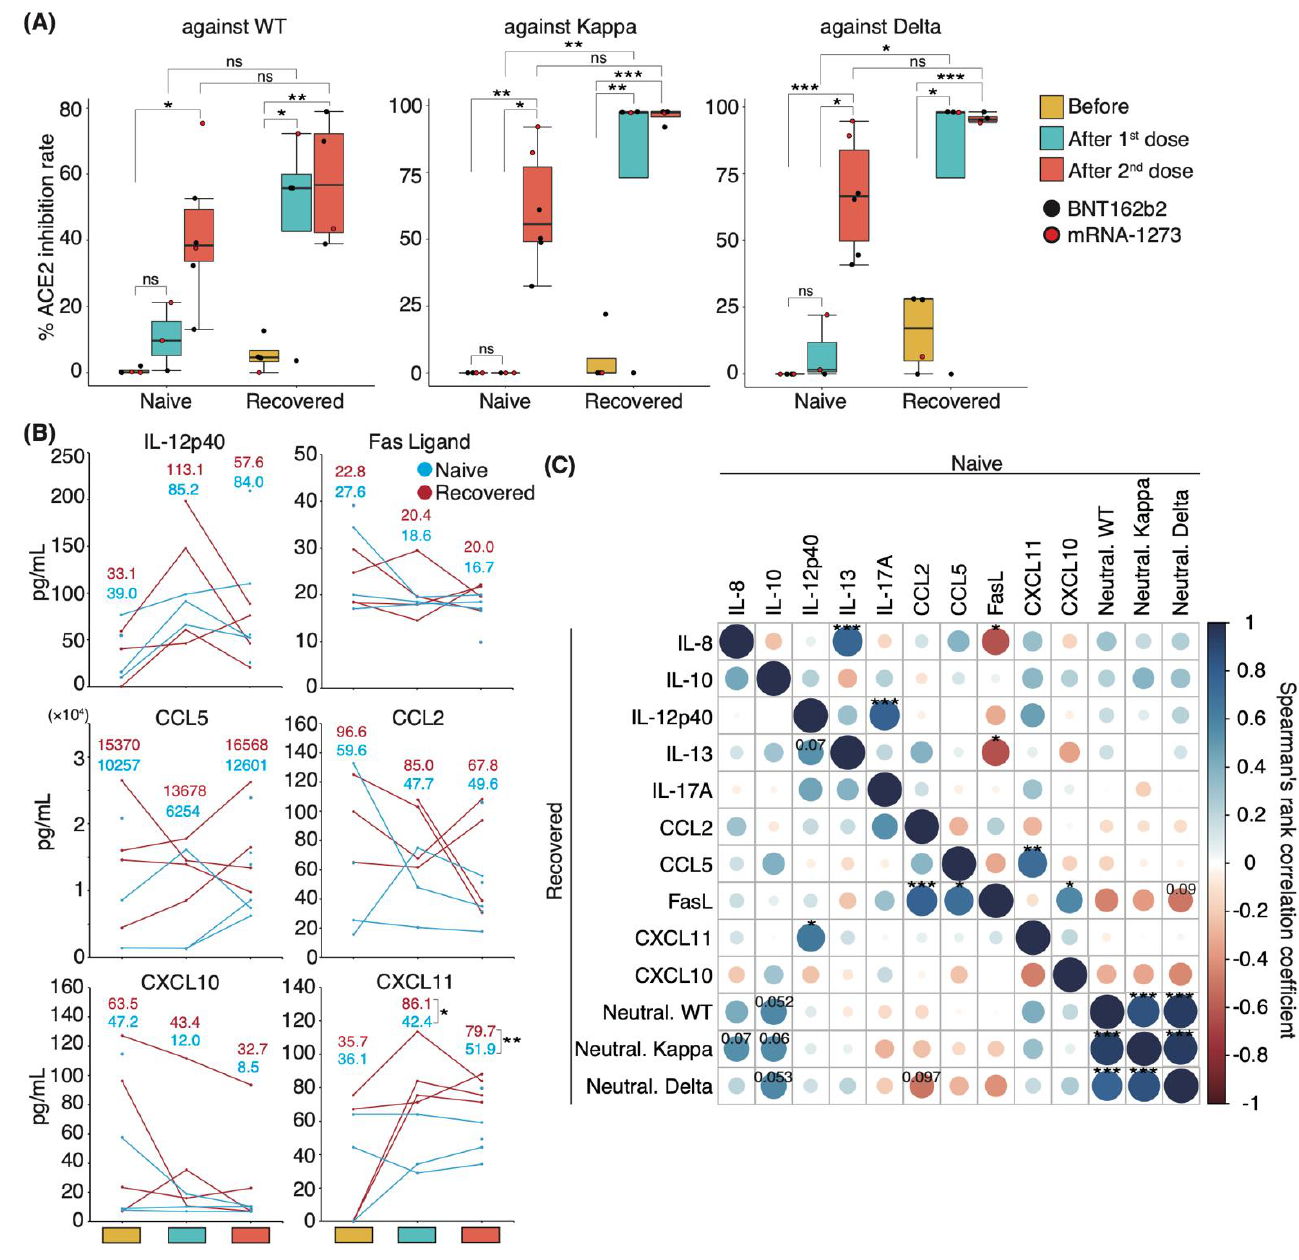
Figure 4. Serum neutralizing potencies and cytokine levels in naïve and recovered individuals after mRNA vaccination: ( A ) Box plots show neutralizing antibody titers against WT, Kappa, and Delta strains in naïve and recovered individuals after vaccination. Statistical significances were determined using Tukey – Kramer test. ( B ) Graphs show representative changes in serum cytokine levels during the vaccination period. Light blue indicates naïve, and red indicates recovered patients. Each mean is shown in the graph. ( C ) Spearman’s rank coefficients for naïve and recovered individuals are shown in an asymmetric correlation plot ( n = 6 participants/naïve group; 4 participants/recovered group). The matrices across three time points for cytokine levels and neutralizing antibody titer, comparing naïve and recovered individuals. Neutral. WT, neutralizing potency for WT strain; Neutral. Kappa, neutralizing potency for Kappa strain; Neutral. Delta, neutralizing potency for Delta strain; * p < 0.05; ** p < 0.01; *** p < 0.005; ns, not significant.